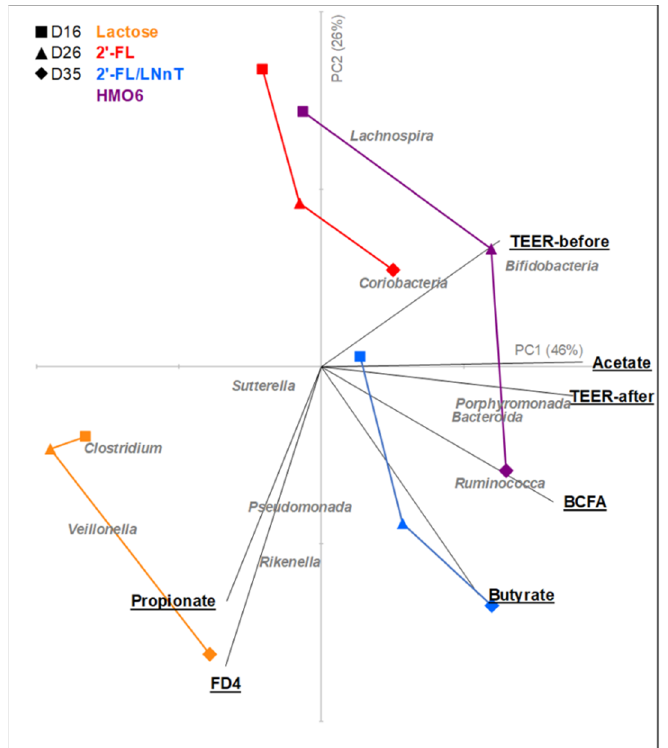
Figure 7. Principal component regression plot representing distal colon microbial activity data, bifidobacteria levels, and intestinal barrier function (TEER and FD4 translocation before and after pro-inflammatory challenge) obtained for 2 (day 16), 12 (day 26), and 21 (day 35) days of treatment with blank control, lactose, 2 ′ -FL, 2 ′ -FL/LNnT, or HMO6. Data were plotted on the first two principal components, contributing to 46% (PCA1) and 26% (PCA2). Lines connect different time points belonging to the same treatment group.